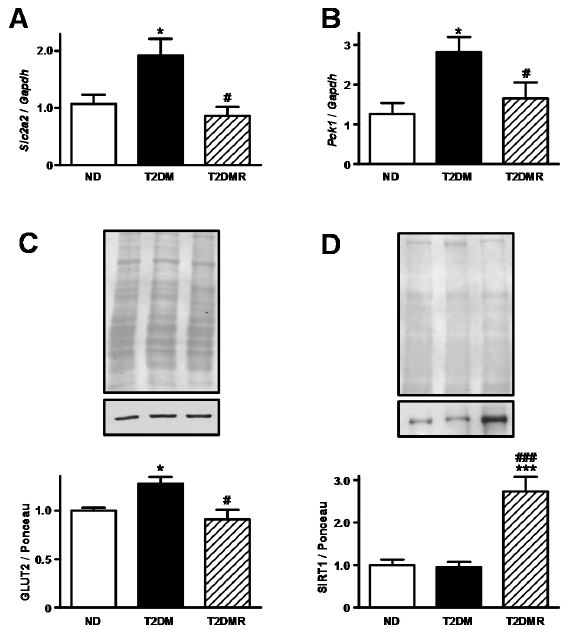
Figure 3. Resveratrol restored Slc2a2 and Pck1 mRNAs and GLUT2 protein expression in the liver of T2DM mice. Slc2a4 mRNA ( A ), GLUT2 protein ( C ), Pck1 mRNA ( B ), and nuclear SIRT1 protein ( D )